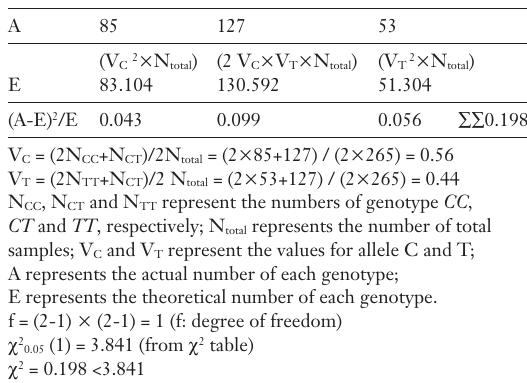
The statistical results of C allelic frequen- cies of the MDR1 C3435T between the data in this study and the other published data (allele C and T; geno- type CC, CT and